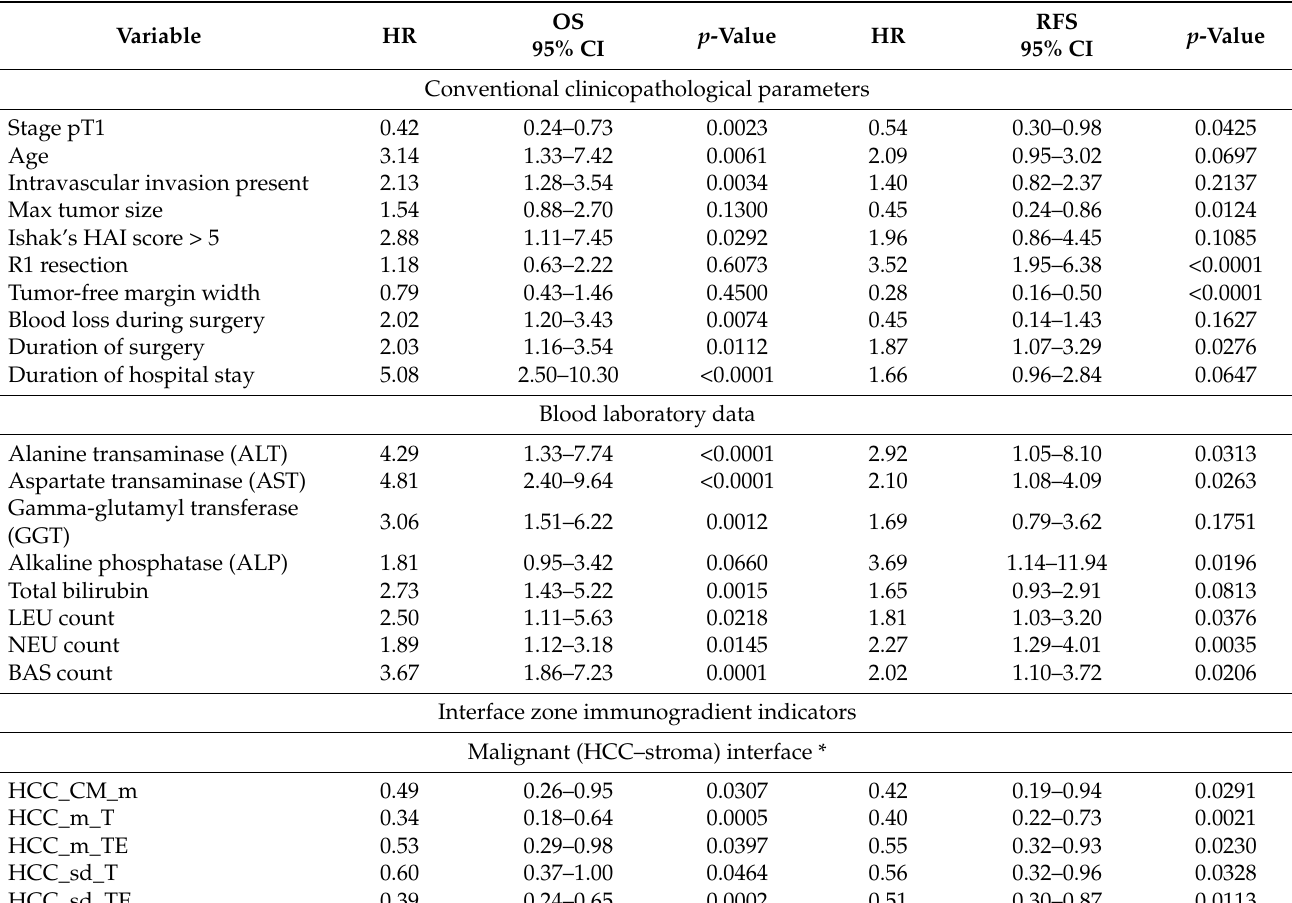
Table 3. Univariate predictors of overall survival and recurrence-free